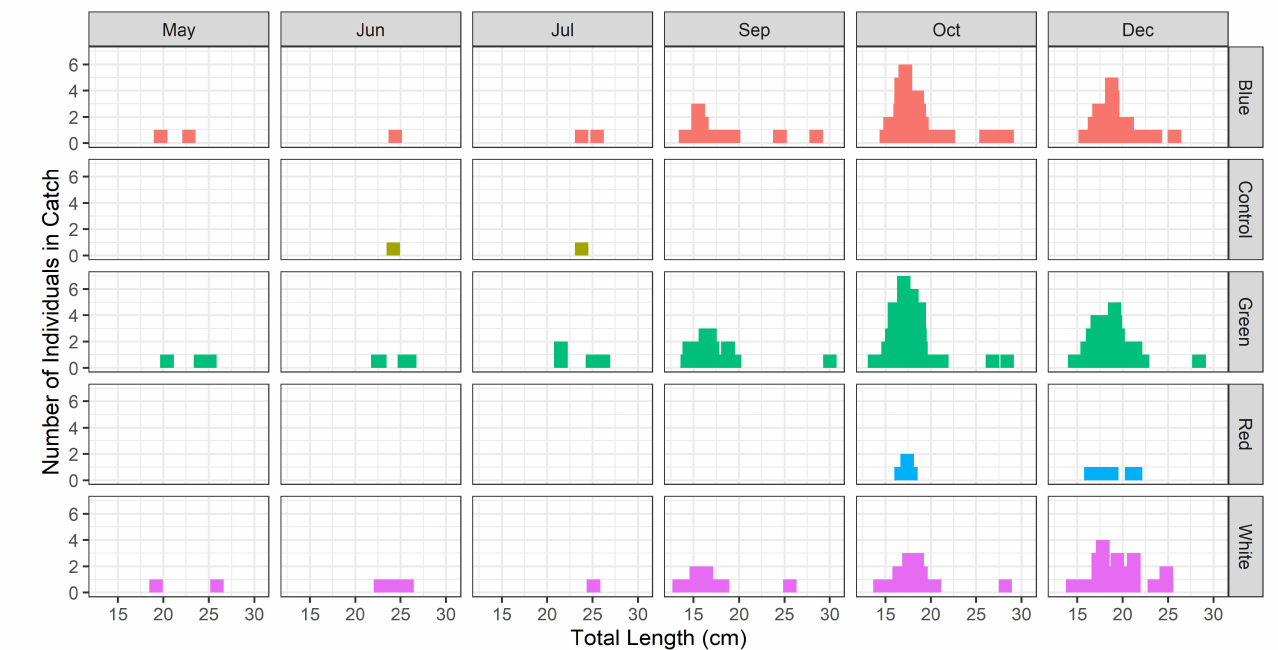
Figure 4. Monthly total length distribution of bluefin sea robin by fishing gear